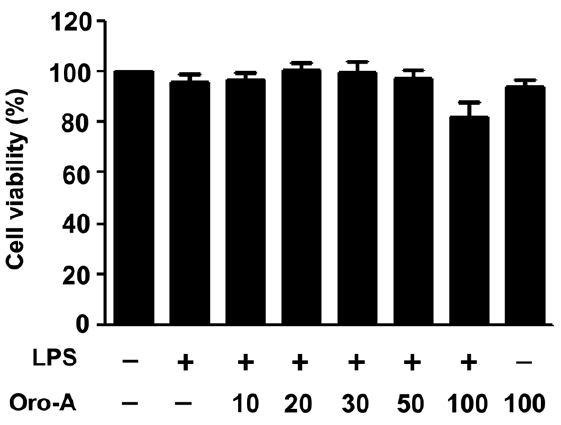
Figure 2. Lack of effect of oroxylin A on iNOS mRNA stability in BV-2 cells. BV-2 cells (5 6 10 4 cells/well) were treated with LPS (100 ng/ ml) for 20 hours. Subsequently, cells were incubated with ActD (0.1 m g/ ml), a transcription inhibitor, and oroxylin A (Oro-A, 50 m M)/vehicle for indicated time periods. Total mRNA was then isolated and iNOS mRNA levels were quantified by real-time RT-PCR. The iNOS mRNA level when ActD was added was regarded as 100%, and the linear regression against time was plotted. Results are means 6 SEM from three independent experiments.